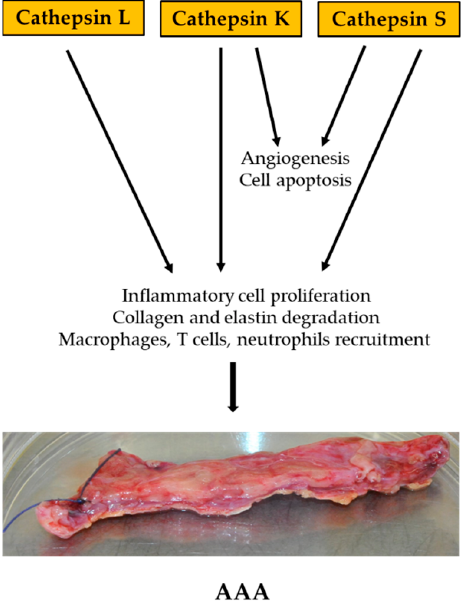
Figure 4. Diagram summarizing the role of cathepsins in AAA formation in vivo.